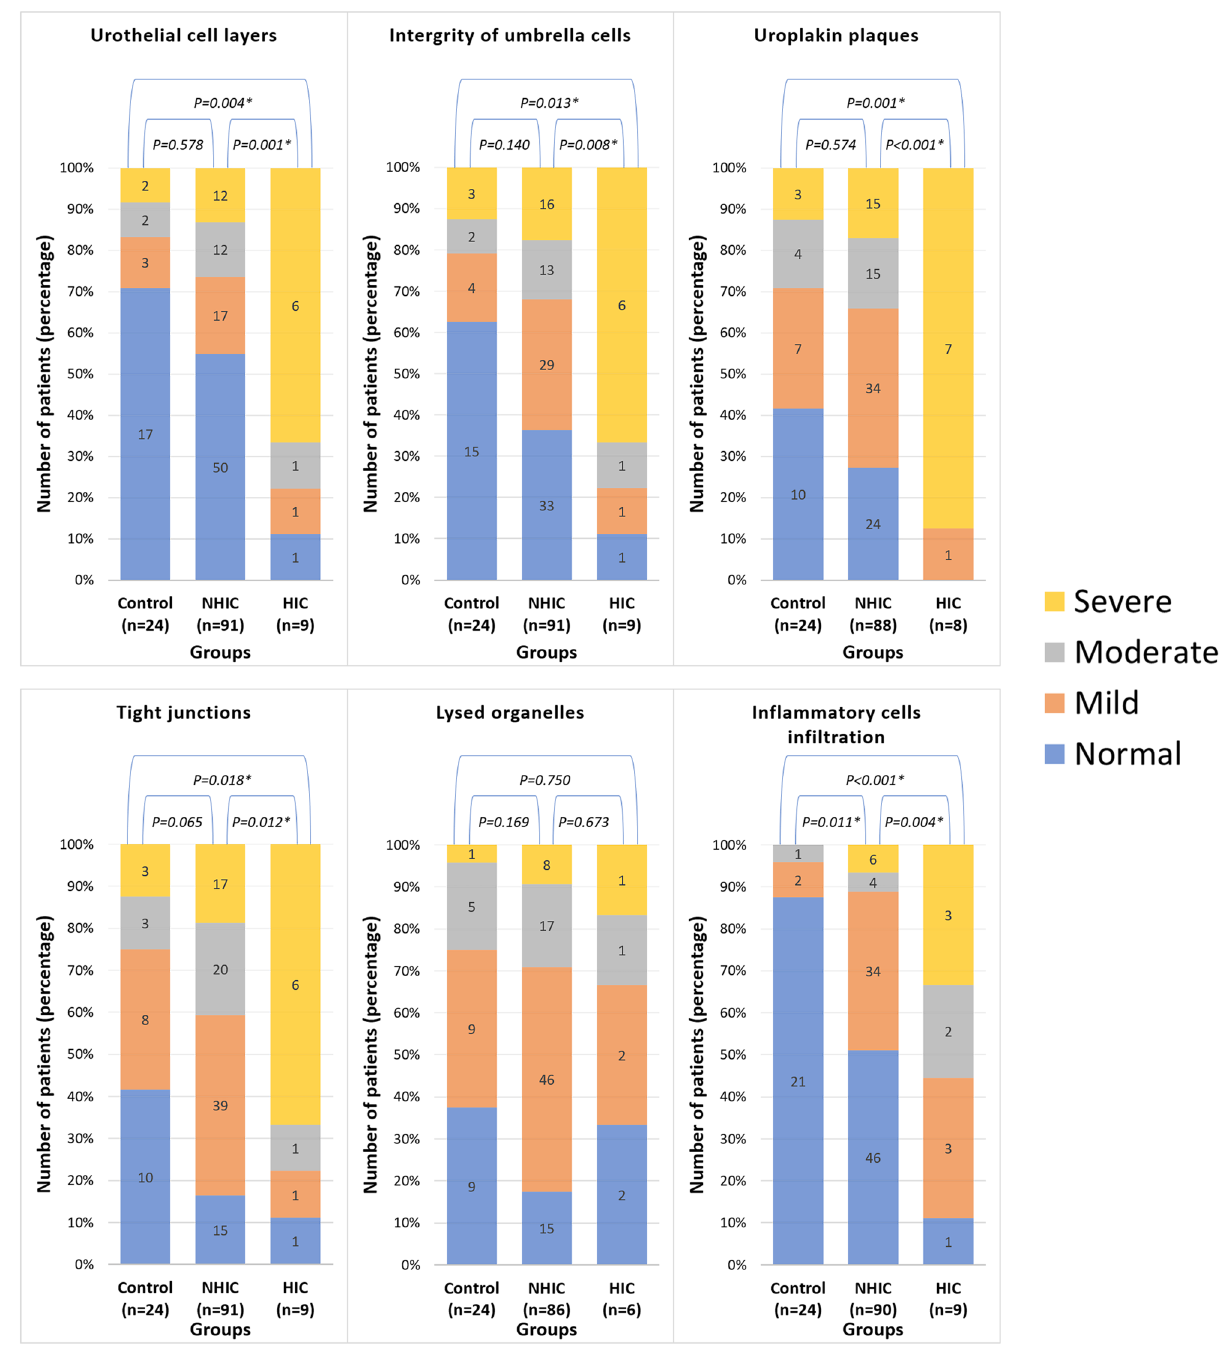
Figure 5. Comparison of urothelium EM defect frequencies among IC/BPS patients (HIC and NHIC) and control subjects. * p < 0.05 by chi-square